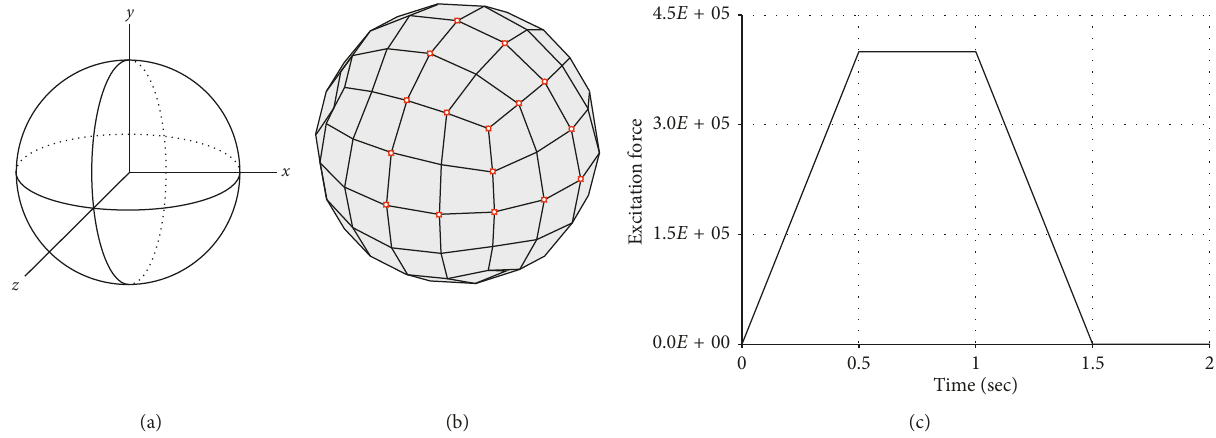
Figure 3: Geometry (a), BEM discretization mesh of the wet surface (b), and time history of excitation force (c). 12.0 –4.0–2.00.02.04.06.08.010.0